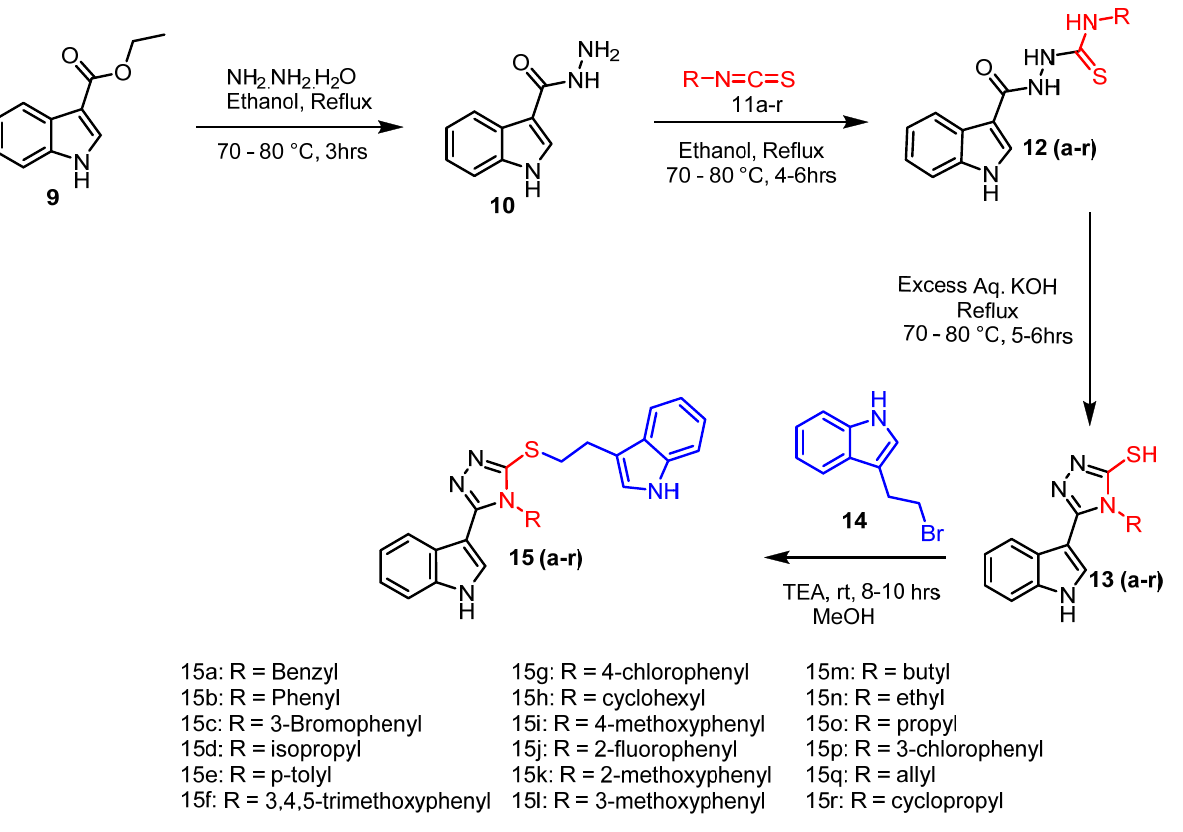
Table 1. Anti-proliferative activity of all the synthesised 1,2,4-triazolo-linked bis -indolyl conjugates ( 15a-r